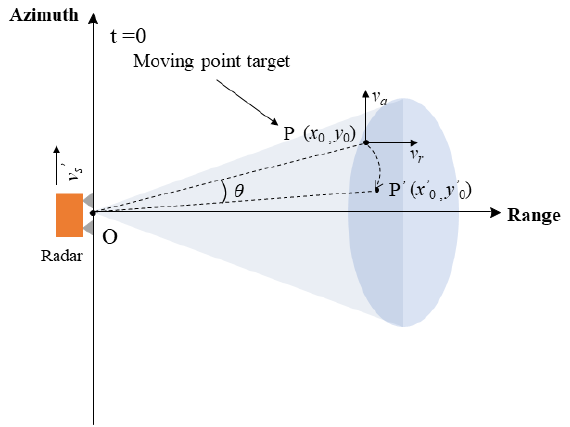
when 0 t = , its velocity is () , vv . After relative speed transformation, the moving r a target P rotates  to P’ as a stationary target. The target position changes fro m